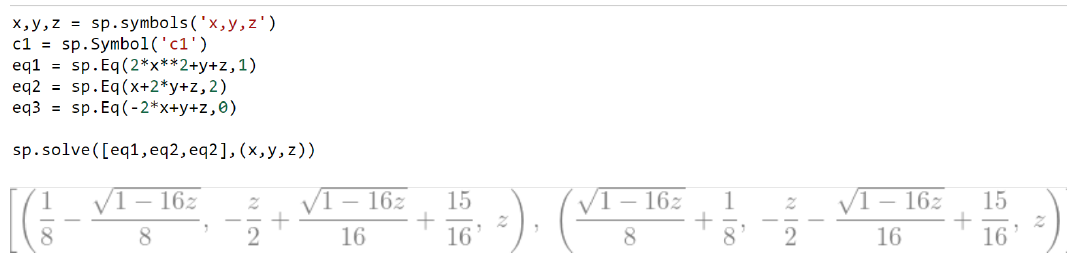
Figure 7. Solving a system of equations.